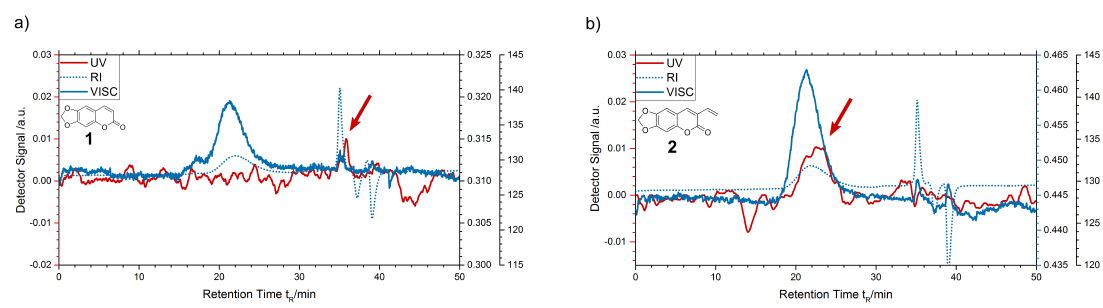
Figure 6. Size exclusion chromatography (SEC) chromatogram of ( a ) ayapin 1 -doped polymer and ( b ) 3-vinylayapin 2 -doped polymer. The blue lines are detector signals of refractive index (dotted) and viscosity detectors (solid), the red lines represent the signal of UV detector.